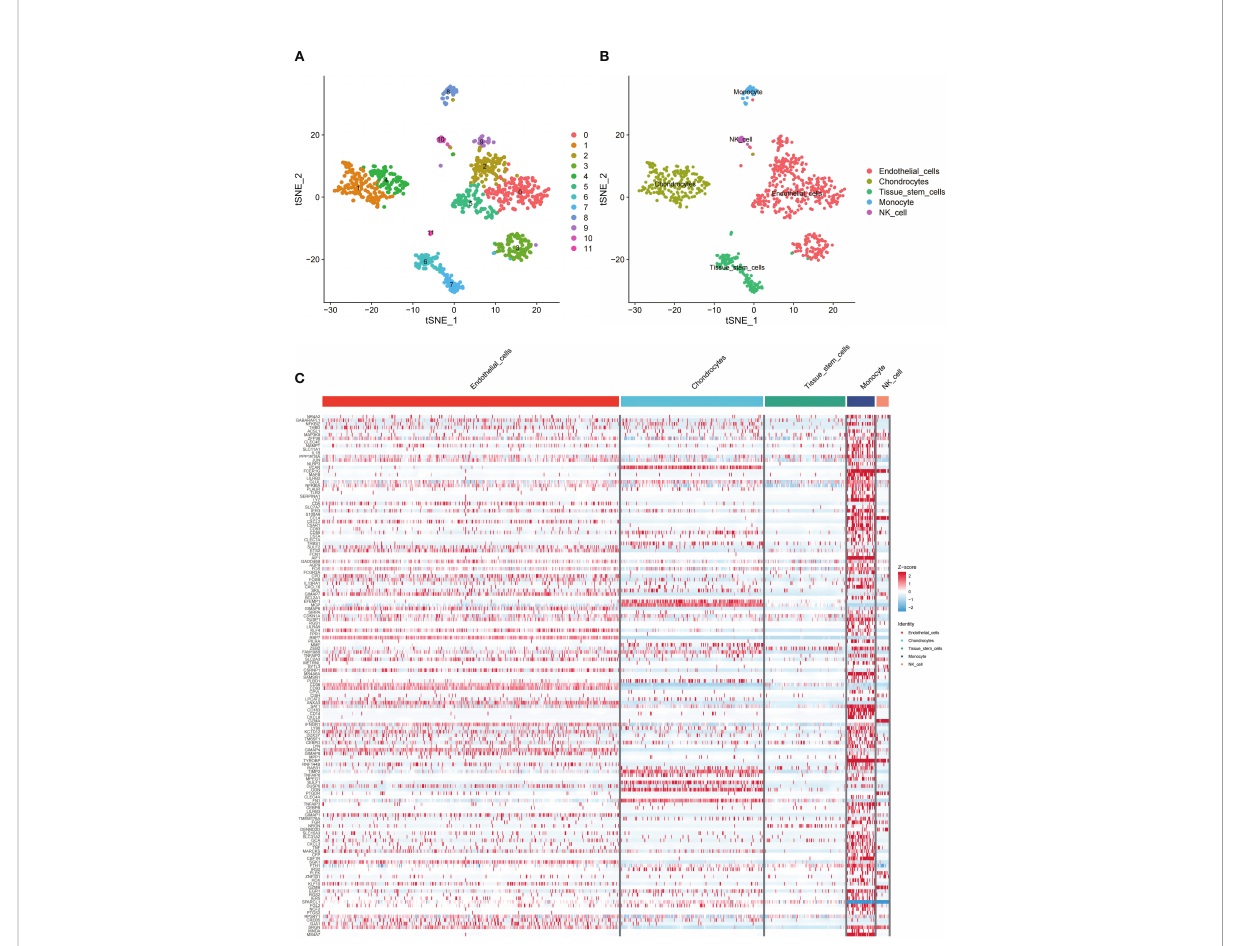
FIGURE 3 Overview of single cells from GSE180678. (A) Clusters of 12 cells embedded in a T-distributed Stochastic Neighbor Embedding (tSNE). (B) Marker genes were used to identify the cell types. (C) Heat map of the distribution and enrichment of DEGs in cell subpopulations.